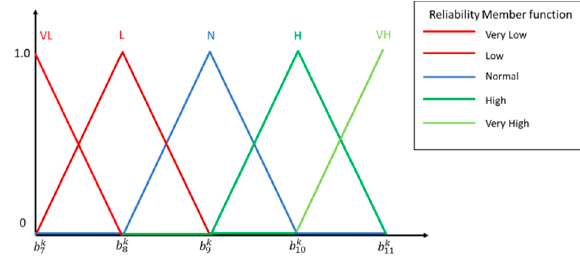
Figure 8. Reliability fuzzy function. Table 4. Example of fuzzy rule library.